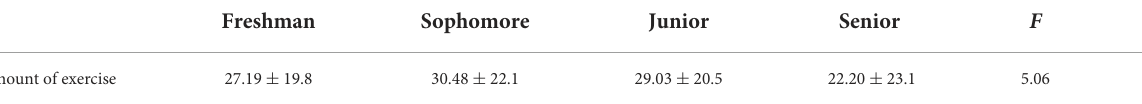
TABLE 3 Test for differences in exercise volume by grade.